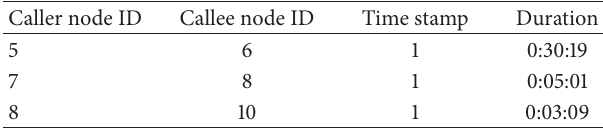
Figure 5: Activity monitoring over timeline. Table 4: Bank transfer database.